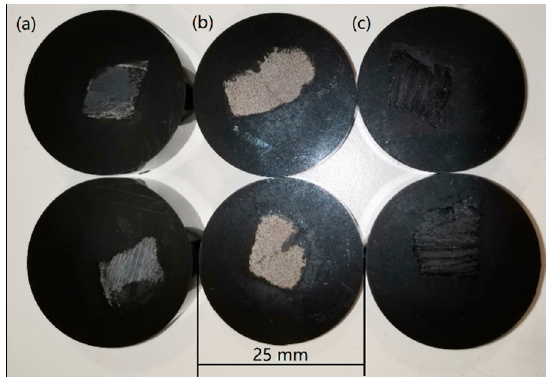
Figure 4. Prepared samples of ( a ) shale, ( b ) mudstone and ( c ) coal.